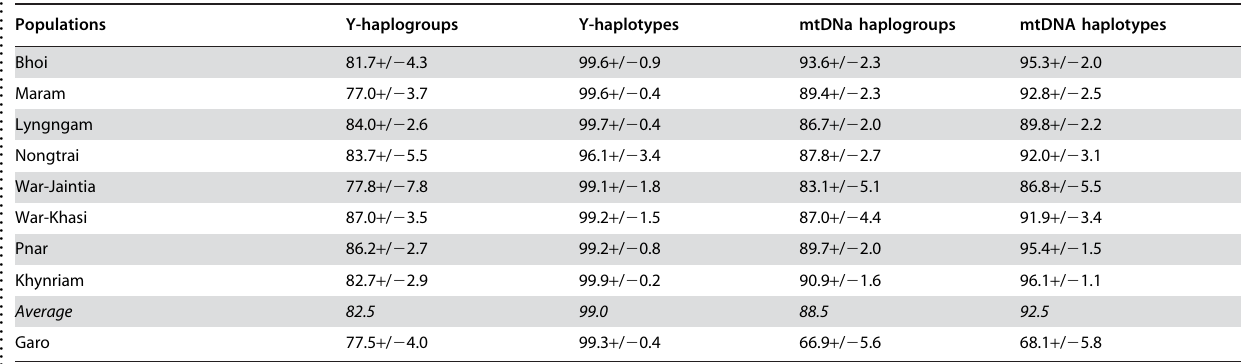
Table 2. Genetic Diversity (in percentage) based on Y-Chromosome and mtDNA analysis of populations from Meghalaya .. ... .... ... ... .... ... ... .... ... ... .... ... ... .... ... ... .... ... ... .... ... ... .... ... ... .... ... ... .... ... ... .... ... ... .... ... ... .... ... ... .... ... ... . Populations Y-haplogroups Y-haplotypes mtDNa haplogroups mtDNA